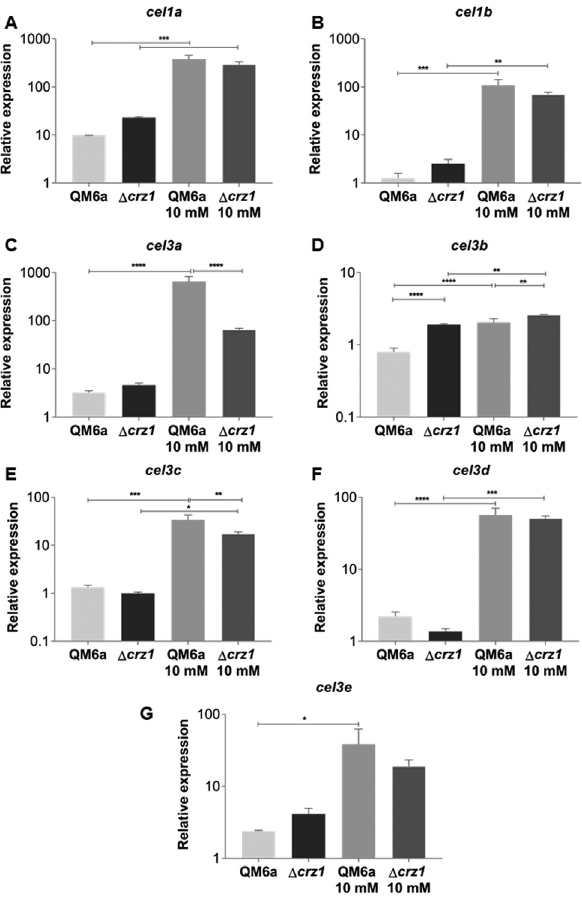
Figure 4 - qRT-PCR results for differential expression analysis of the (cid:6) -glucosidases genes of T. reesei in the QM6a and (cid:2) crz1 strains after 8 h ofgrowinginSCBsupplementedornotwith10mMCa 2+ .Expressionval- ues are represented as log 10 means of three biological replicates with stan- darddeviationnormalizedbyglycerolexpressionlevelsatthesamecondi- tion. Statistical significance is represented as asterisks, considering p-value as <0.05 (*), <0.01 (**), <0.001 (***) and p<0.0001